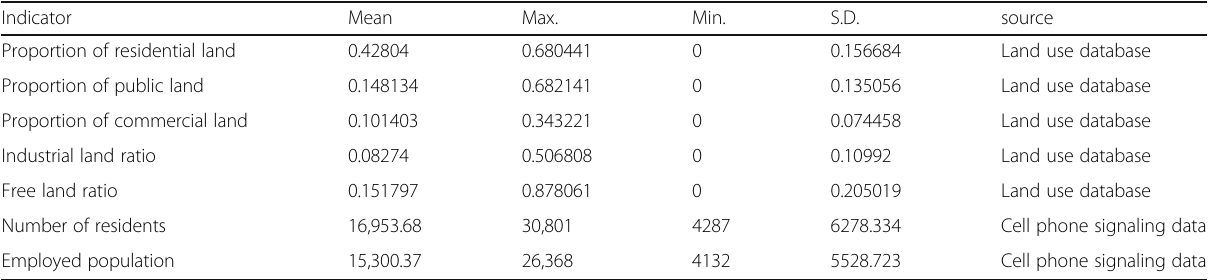
Table 1 Indicators for the classification of Xi ’ an rail transit stations